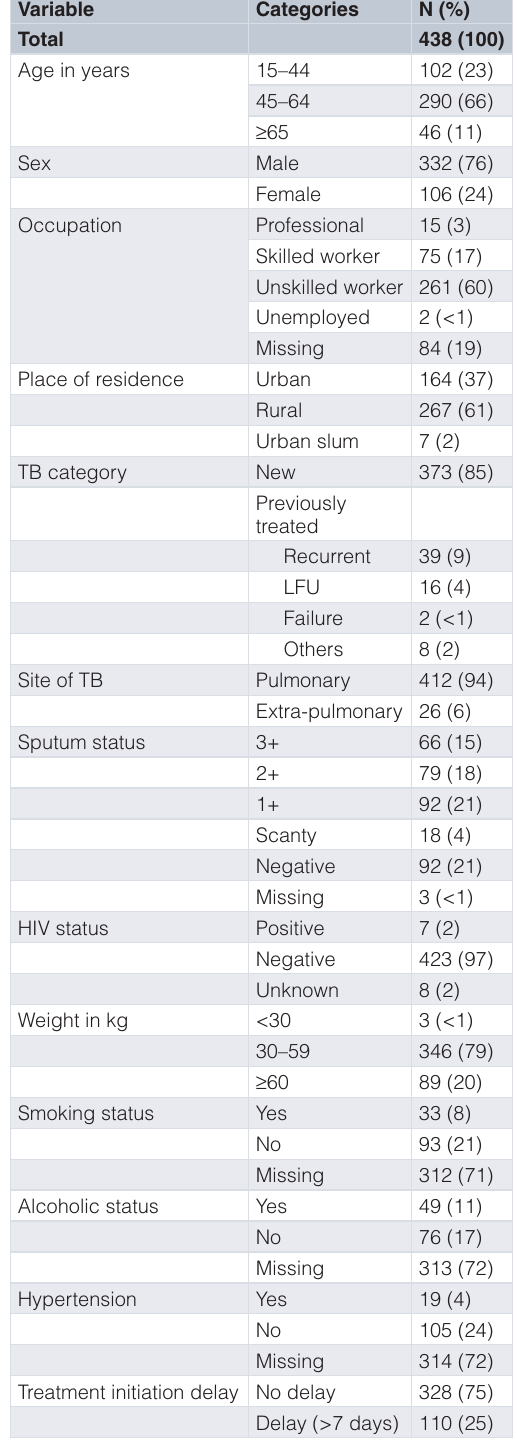
Table 1. Baseline socio-demographic and clinical profile of patients with TB-DM registered in RNTCP in select districts of Tamil Nadu, India (Jan–Sept